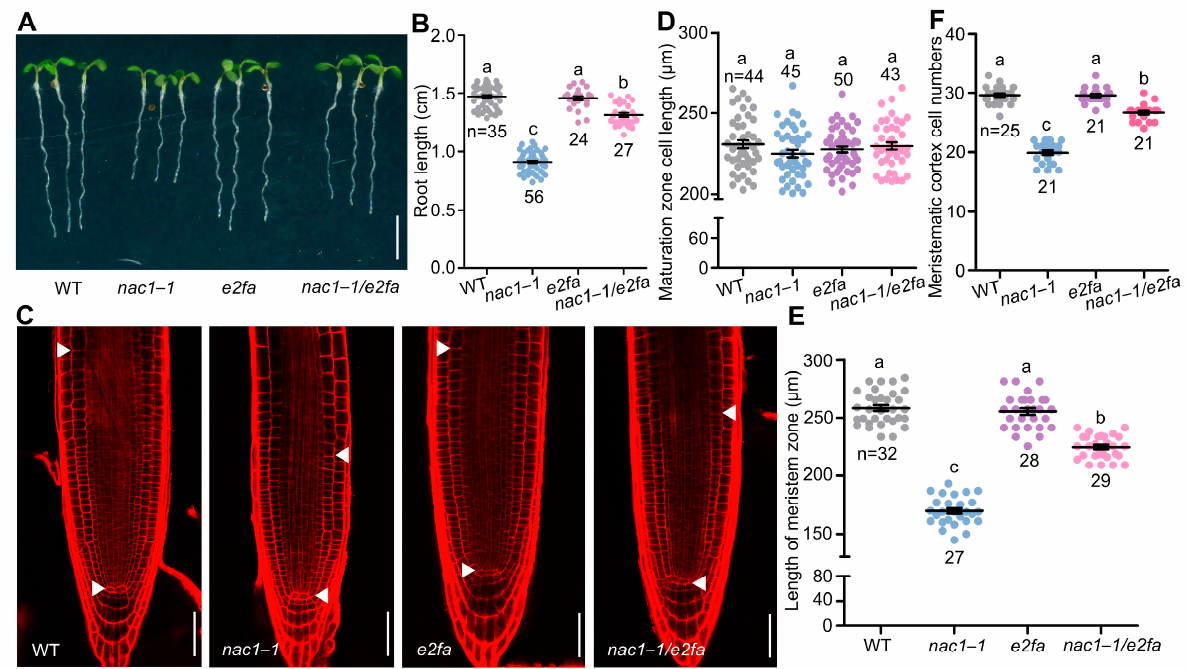
Figure 4. E2Fa acts downstream of NAC1 to control root growth. ( A ) The root growth phenotypes of WT, nac1–1 , e2fa , and nac1–1/e2fa grown on 1/2 MS medium. The seedlings were photographed at 5 dpg. Scale bar represents 0.5 cm. ( B ) Measurements of primary root length of WT, nac1–1 , e2fa , and nac1–1/e2fa as shown in ( A ). ( C ) Confocal images of root tips of WT, nac1–1 , e2fa , and nac1–1/e2fa as shown in ( A ). The seedlings were used at 5 dpg for imaging. White arrows indicate the boundary between root meristem and transition zones. White arrows below indicate the QC. Scale bars represent 50 µ m. ( D ) Root cortical cell length in the maturation zone of 5 dpg seedlings as shown in ( C ). ( E ) Length of meristem zone of 5 dpg seedlings as shown in ( C ). ( F ) Cell numbers in the proliferation domain of 5 dpg seedlings as shown in ( C ). Data information: in ( B , D – F ), data represent mean ± SD, n denotes the total number of scored samples. Individual values (black dots) are shown. Different lowercase letters indicate significant differences by one-way ANOVA followed by Tukey’s multiple comparison test ( p <